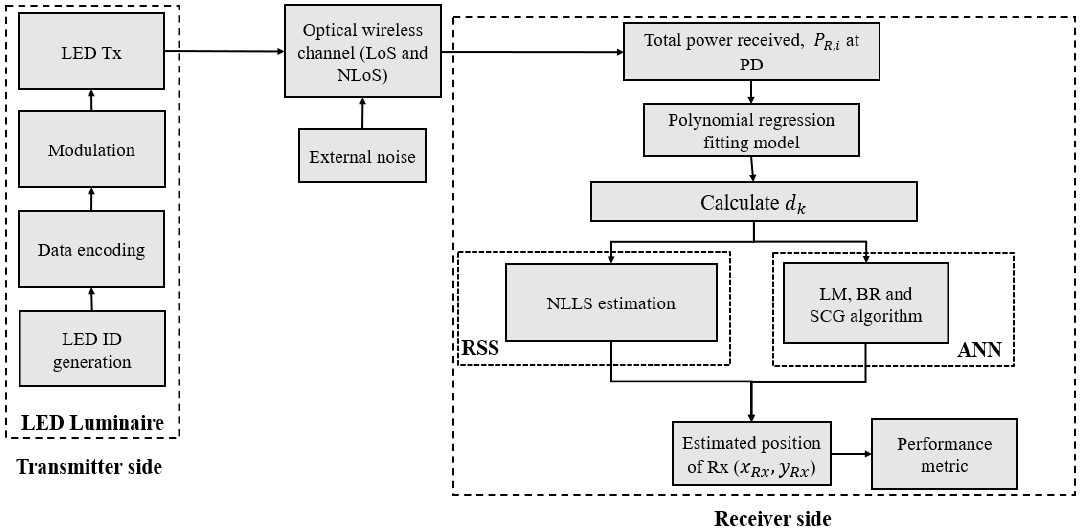
Figure 2. Block diagram of the proposed system.